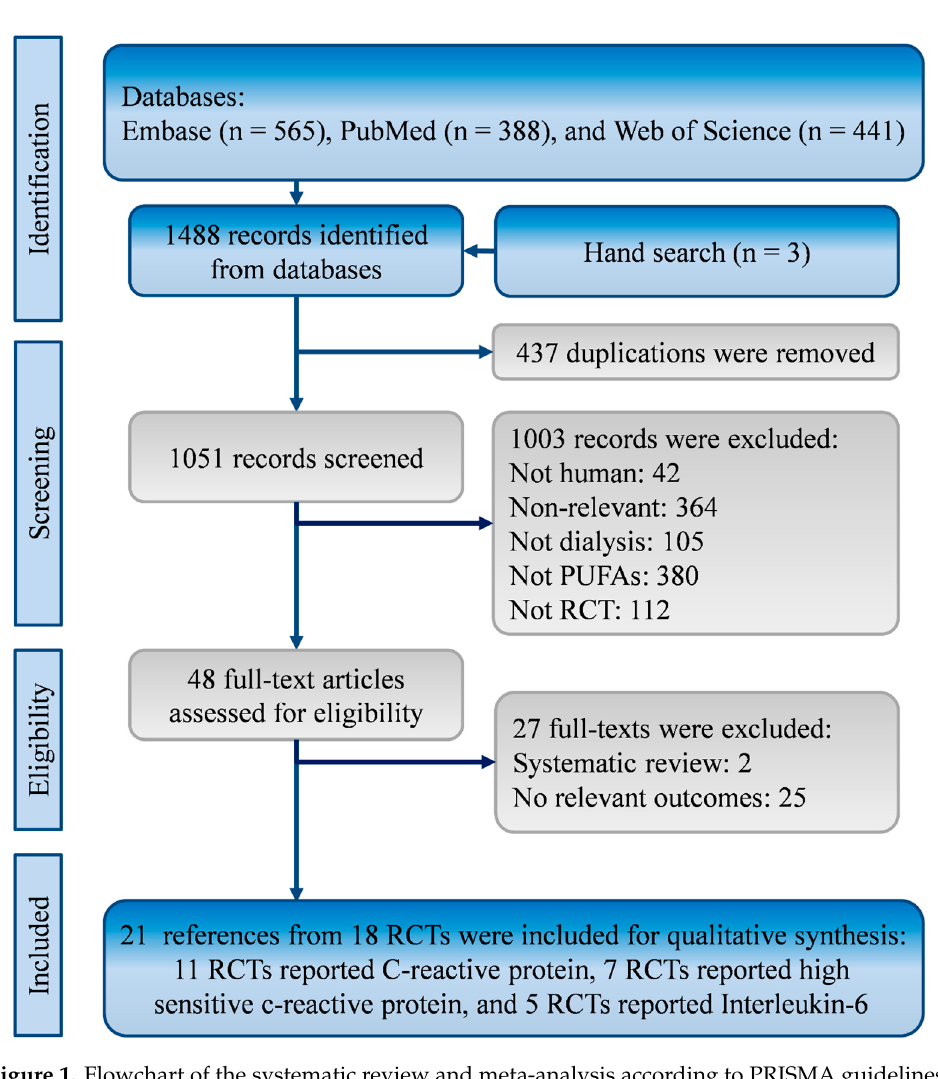
Figure 1. Flowchart of the systematic review and meta-analysis according to PRISMA guidelines.